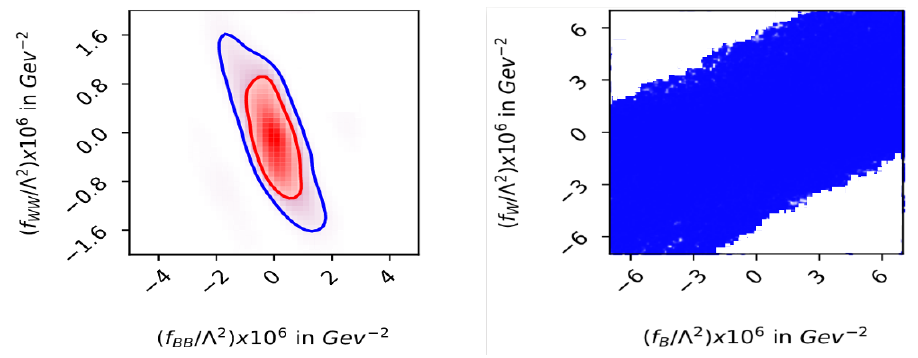
Figure 4 . (left) Allowed regions at 1 (cid:27) (red) and 2 (cid:27) (blue) levels in the f BB - f WW plane and (right) allowed region at 2 (cid:27) level in the f B - f W